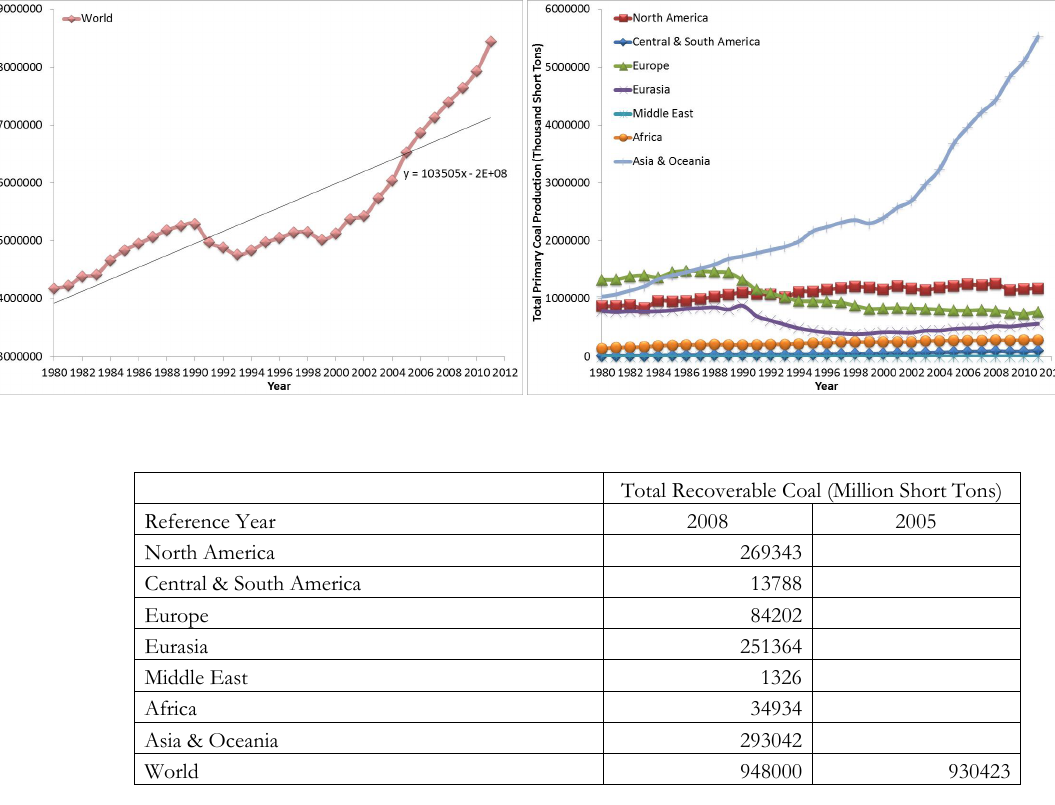
Fig. 3. (a) Coal production according to the U.S. Energy Information Administration [35]. www.eia.gov/cfapps/ipdbproject/iedindex3.cfm? tid=1{&}pid=7{&}aid=1{&}cid=regions{&}syid=1980{&}eyid=2012{&}unit=TST (b) Coal proved reserves according to the U.S. Energy Information Administration [35]. The 2008 data are from www.eia.gov/cfapps/ ipdbproject/IEDIndex3.cfm?tid=1&pid=7&aid=6 The 2005 data are